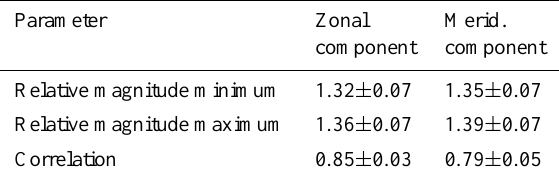
Table 5. Mean and standard deviation of daily relative magnitude minima and maxima for IDI without use of radial velocity threshold relative to FCA-large for 19 January 2000 to 3 February 2000.